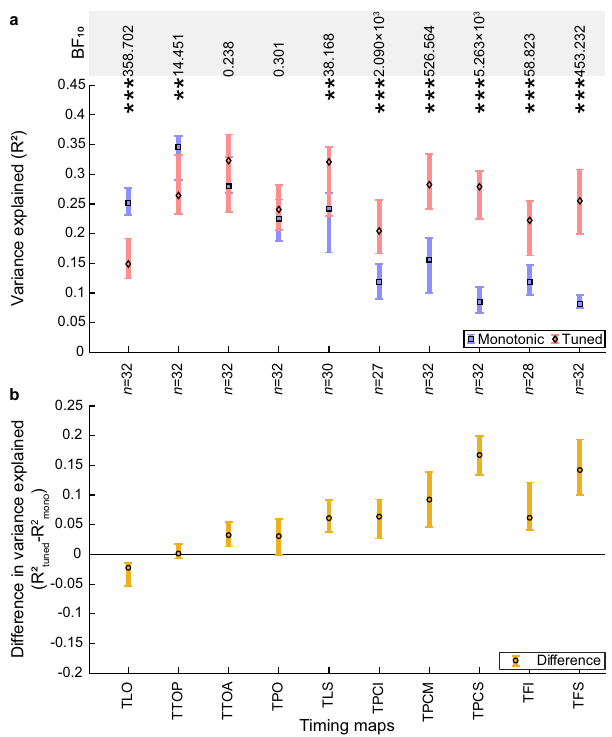
Fig. 7 Comparison of fi ts of monotonic and tuned response models in each timing map. a Cross-validated variance explained by the monotonic and tuned response models. b Difference in cross-validated variance explained between models (tuned – monotonic) progressively changes from monotonic to tuned up the timing map hierarchy. Markers show the median variance explained of each timing map, error bars show the 95% con fi dence interval, computed from 1000 bootstrap iterations. Only the voxels that had a variance explained above 0.2 for the best fi tting model in the data on which the models were fi t are included. Signi fi cant differences between the models (two-sided Wilcoxon signed-rank test, FDR corrected for multiple comparisons): * p < 0.05 ** p < 0.01, and *** p < 0.001. n indicates the number of hemispheres included in the comparison in each timing map (for both panels). Bayes factors (BF 10 ) for each paired comparison are presented in the top row. Source data are provided as a Source Data fi